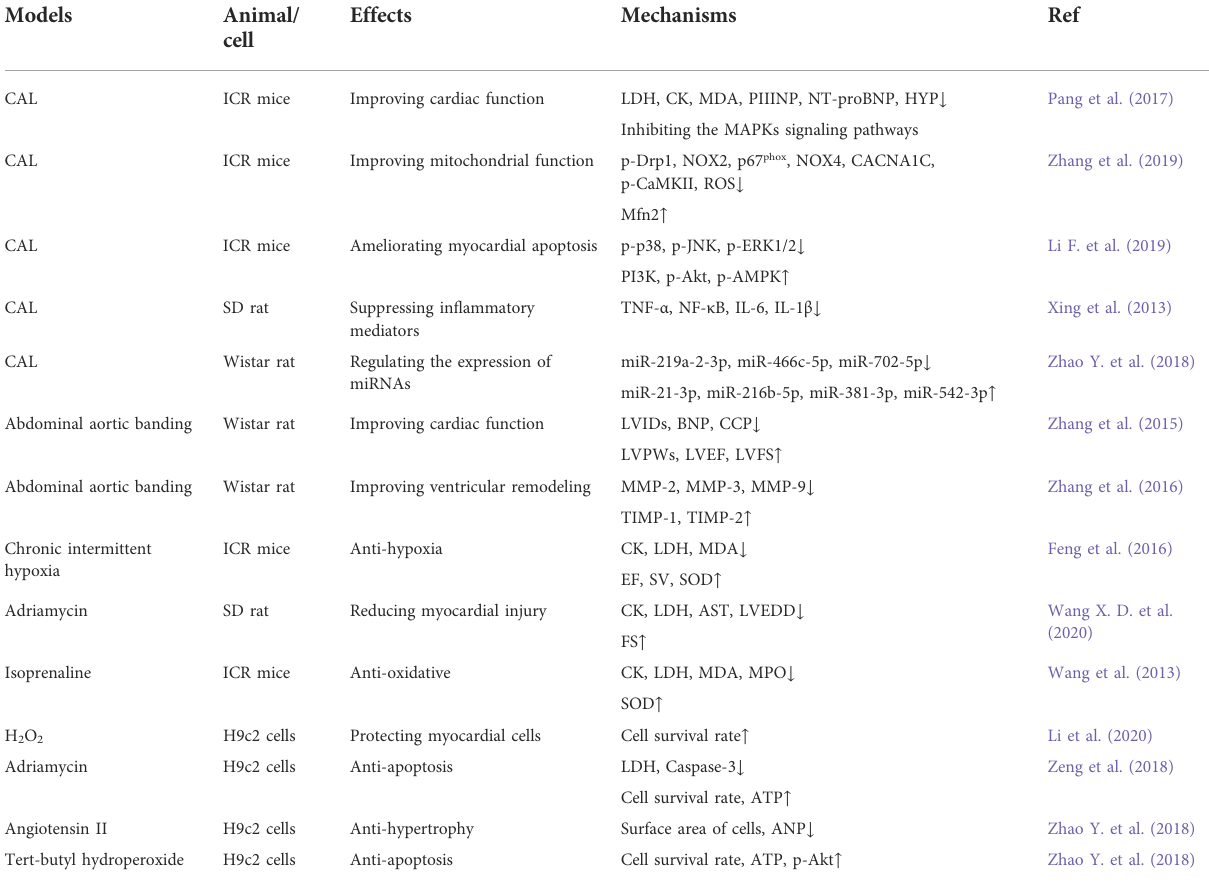
TABLE 2 Myocardial protective effects and mechanisms of YiQiFuMai injection.